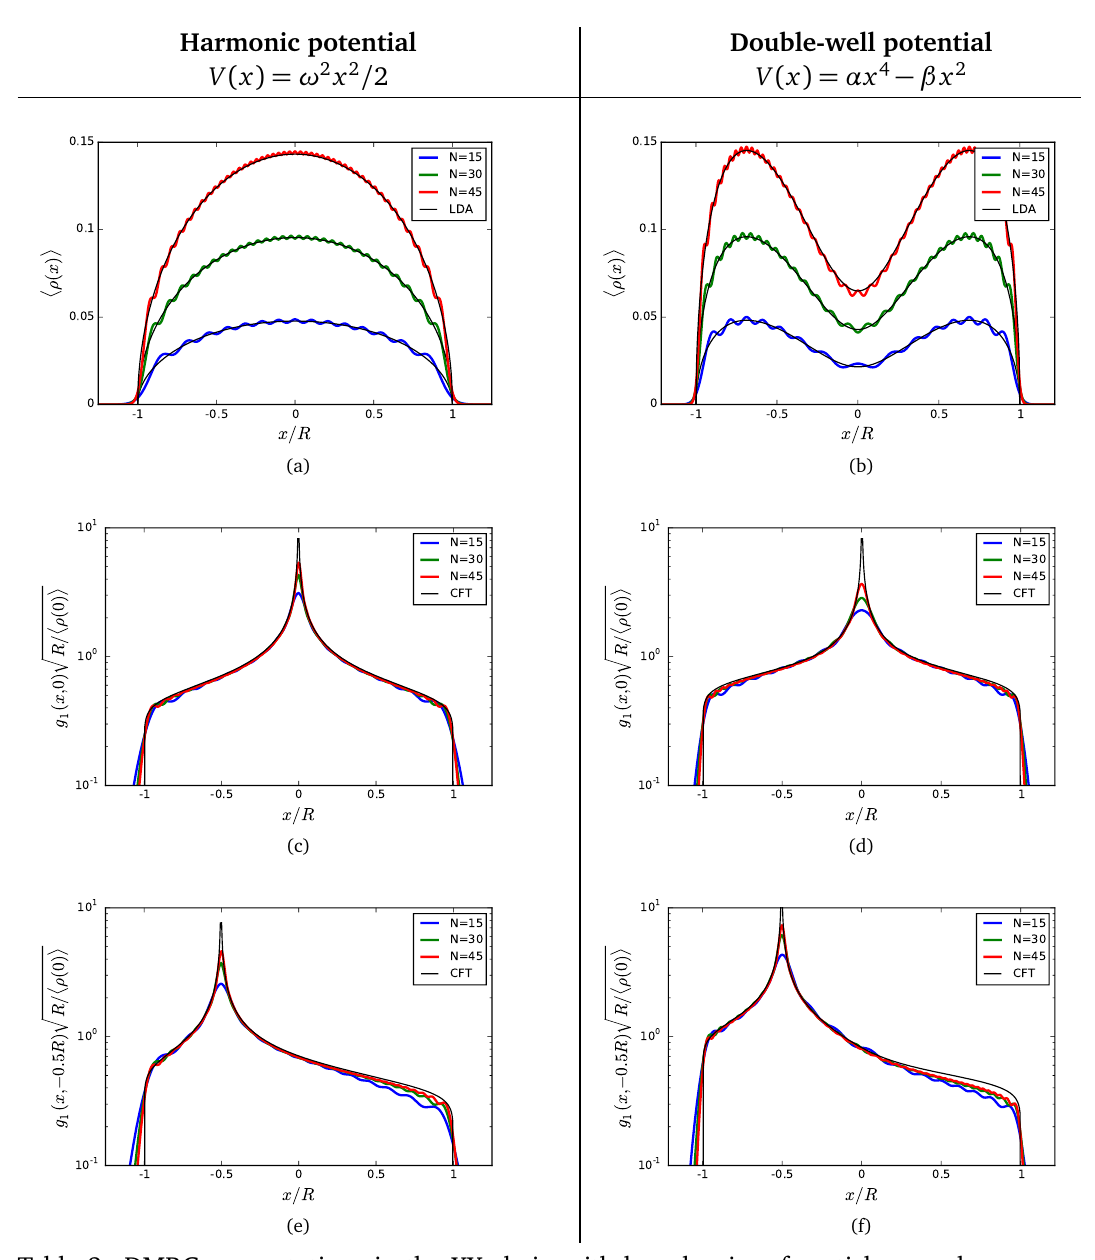
Table 2: DMRG computations in the XX chain with low density of particles, used as an ap- proximation to the continuous Tonks-Girardeau gas. In all the figures, the number of trapped particles is denoted by N . The top row shows the local density 〈 ρ ( x ) 〉 for both the harmonic potential trap (a) and the double-well potential (b), which serves to check that the LDA is ( x , x (cid:48) ) are plot against x / R , for x (cid:48) = 0 applicable. In the next two rows the correlations g 1 in plots (c) and (d), and x (cid:48) = − 0.5 R in plots (e) and (f). The correlations are normalized by (cid:112) R / 〈 ρ ( 0 ) 〉